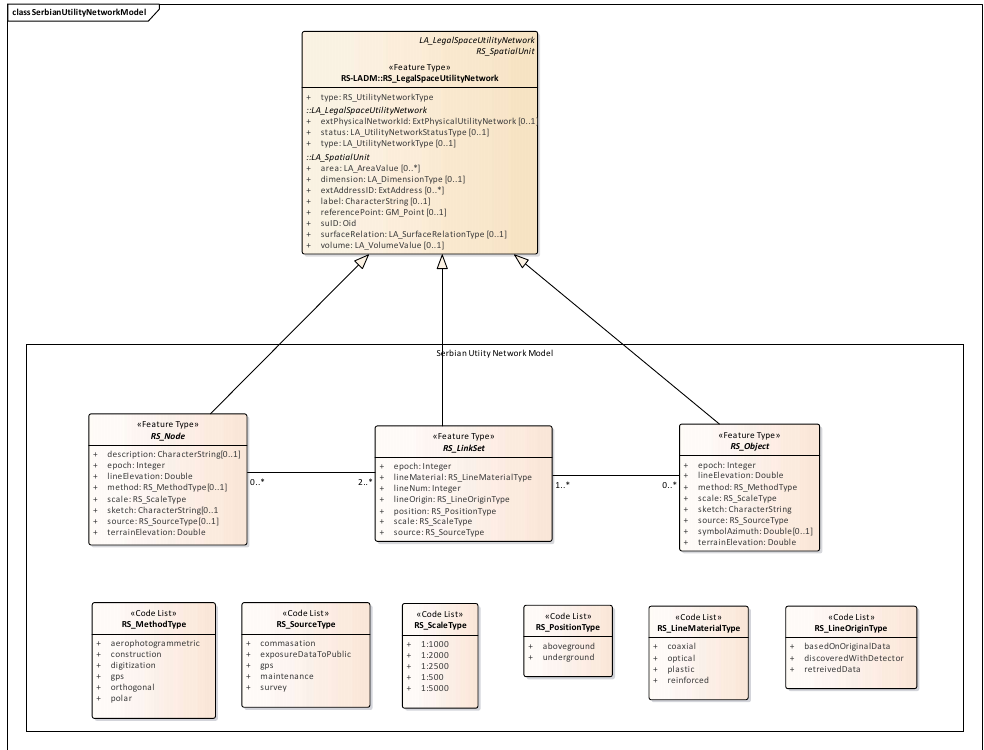
Figure 4. The Serbian Utility Network Model.